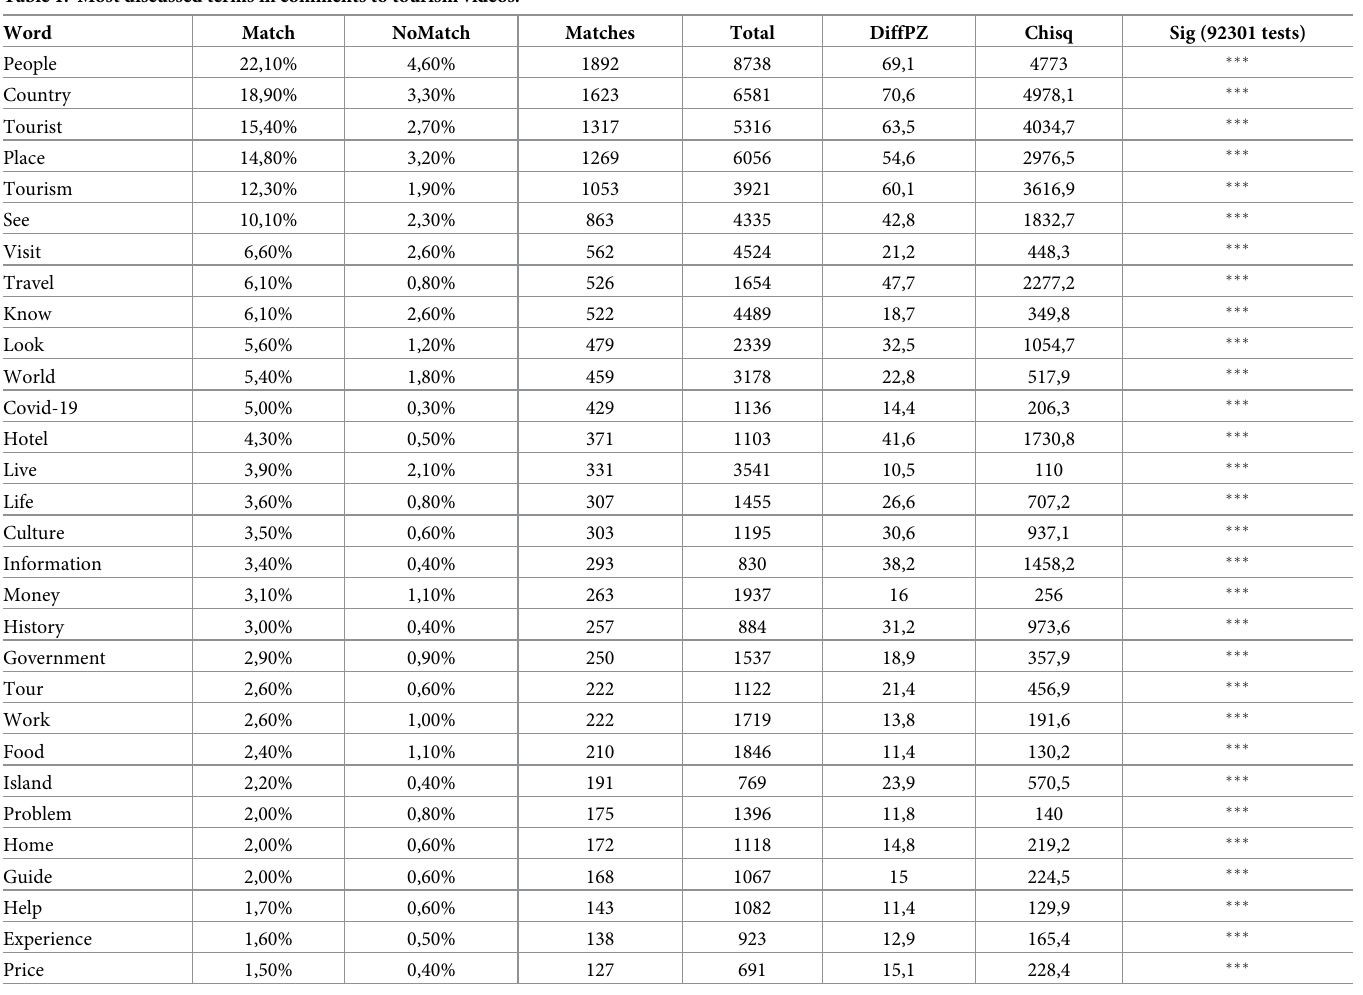
Table 1. Most discussed terms in comments to tourism